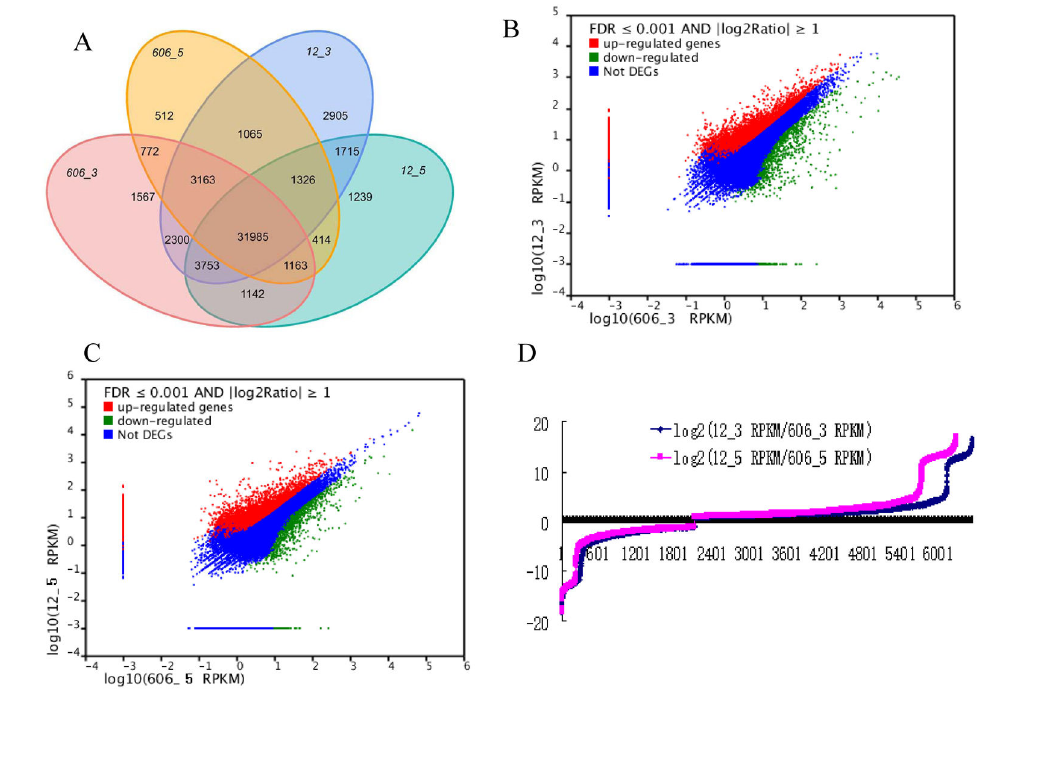
Figure 4. A comparison of differential unigene expression profiles among the different peanut tissues. (A) Distribution of Unigenes from mRNA-seq from the different seed tissues; (B) Expression level in 606-3vs 12-3; (C) Expression level in 606-5vs 12-5; (D) The number of upregulated or downregulated Unigenes. doi: